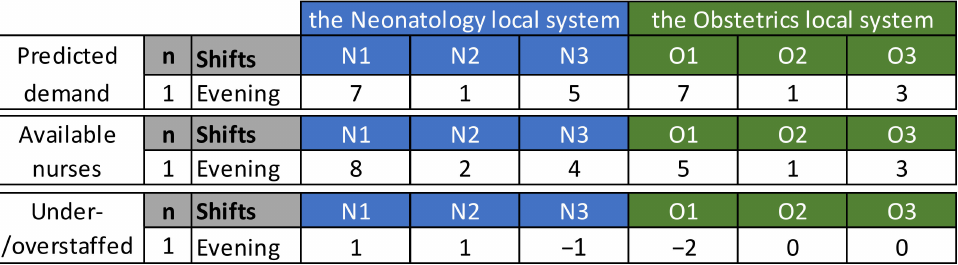
Figure 5. Example of predicting the need for extra nurses.